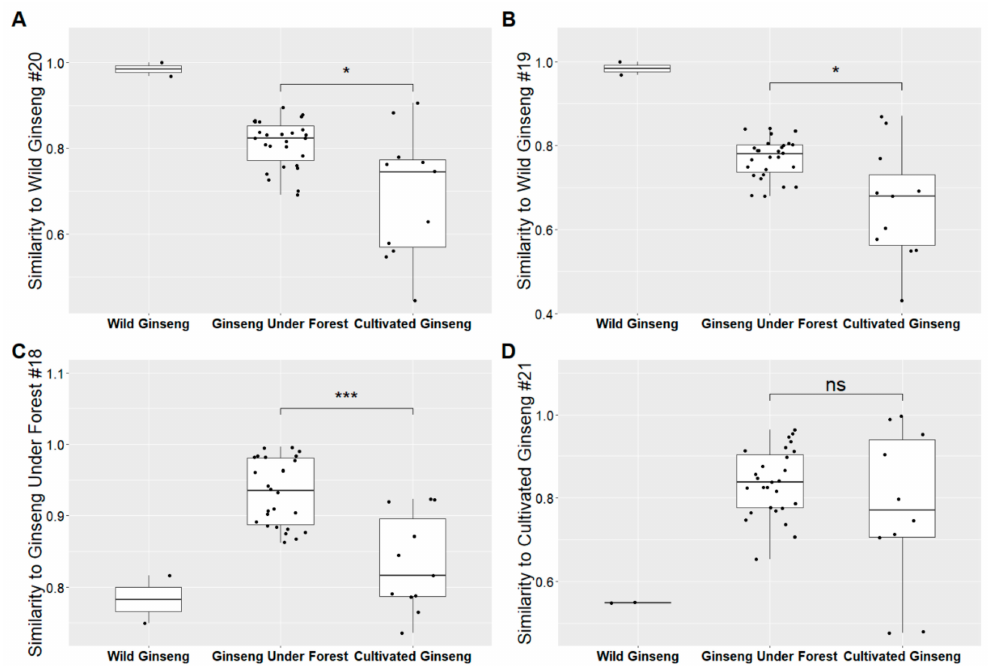
Figure 6. Similarities of HPLC-DAD fingerprints of 40 ginseng samples to wild ginseng (no. 20, A ; no. 19, B ), ginseng under forest (no. 18, C ), and cultivated ginseng (no. 21, D ; ns—no significance, * p < 0.05, *** p < 0.001 between